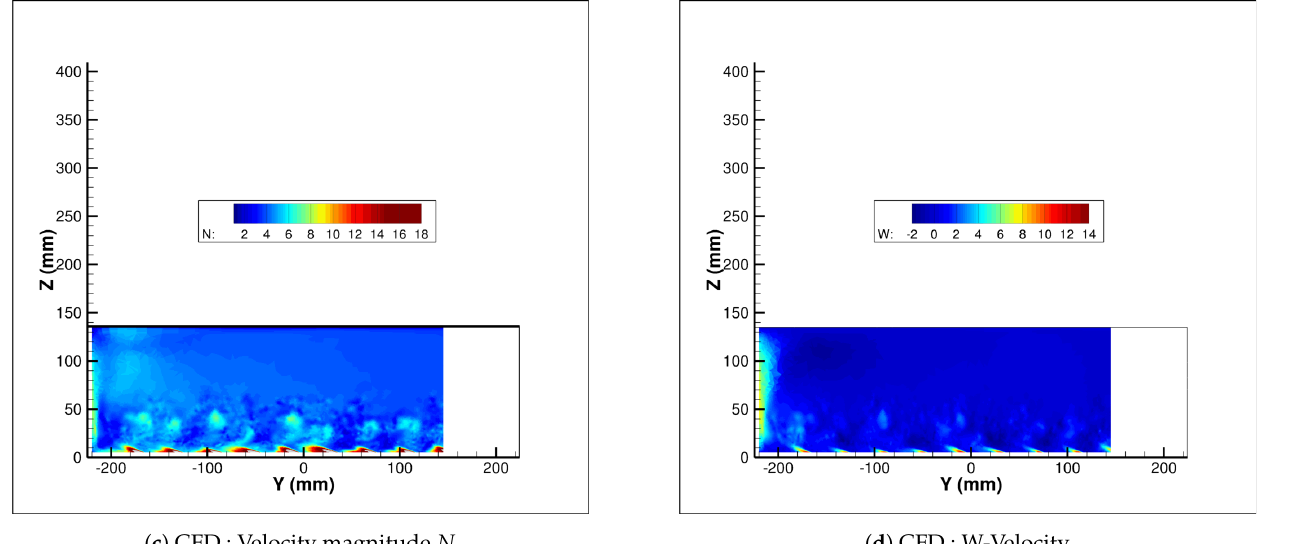
Figure 13. SPIV versus CEDRE EBRSM Velocity fields for X-plane X = 73.5 mm localized on the 2nd row.